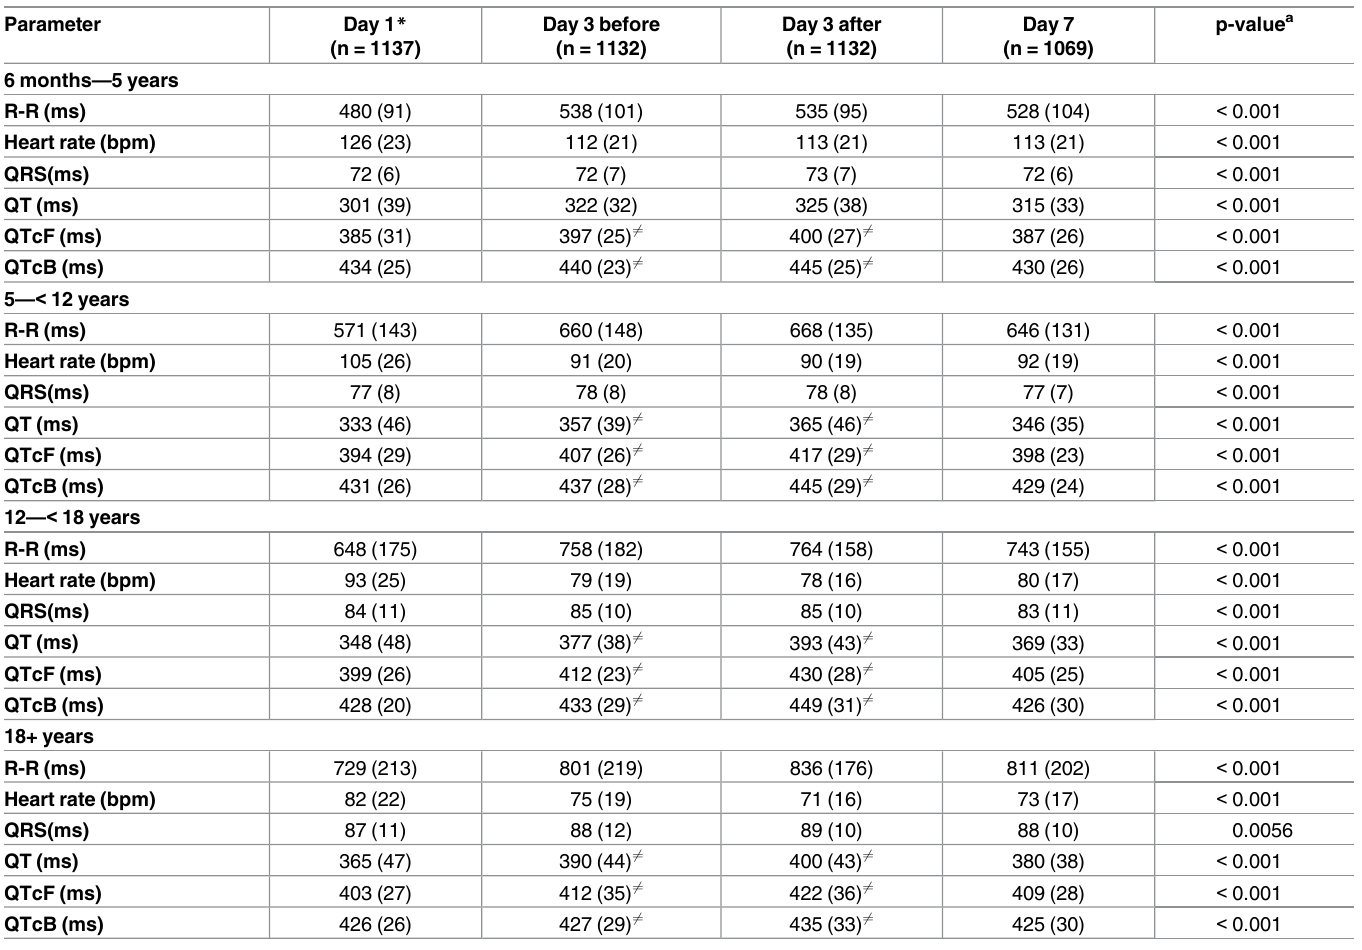
Table 4. Electrocardiogram